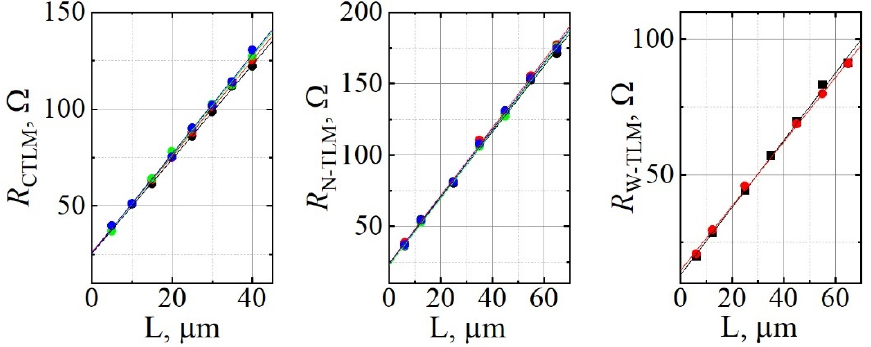
Figure 4. CTLM, N-TLM, and W-TLM graphs for resistance dependence on contact separation distance. Symbols represent measurement data and solid lines indicate linear fit.